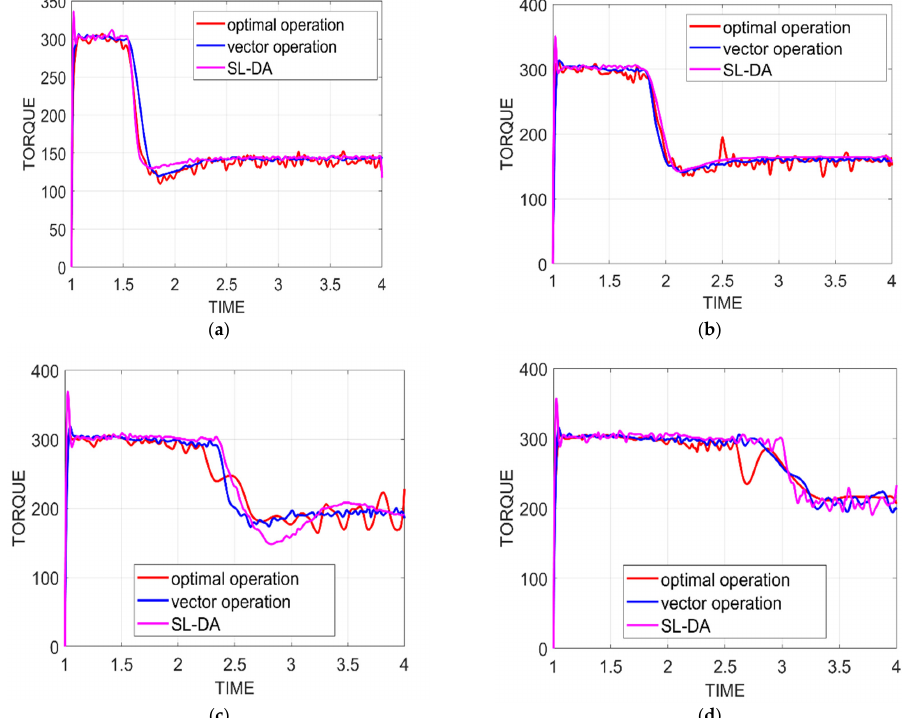
Figure 12. Torque analysis of proposed work over conventional models: ( a ) speed 90 and torque 130; ( b ) speed 120 and torque 150; ( c ) speed 150 and torque 180; and ( d ) speed 180 and torque 200. Analysis of torque graph under four configurations has been performed between the proposed SL-DA and PSO models. The results can be seen in Figure 13. From the obtained results, we can observe that there is more smoothness in the torque graph, and ripples are slightly minimized. Hence, the proposed SL-DA algorithm shows better results as com- pared to the PSO algorithm.